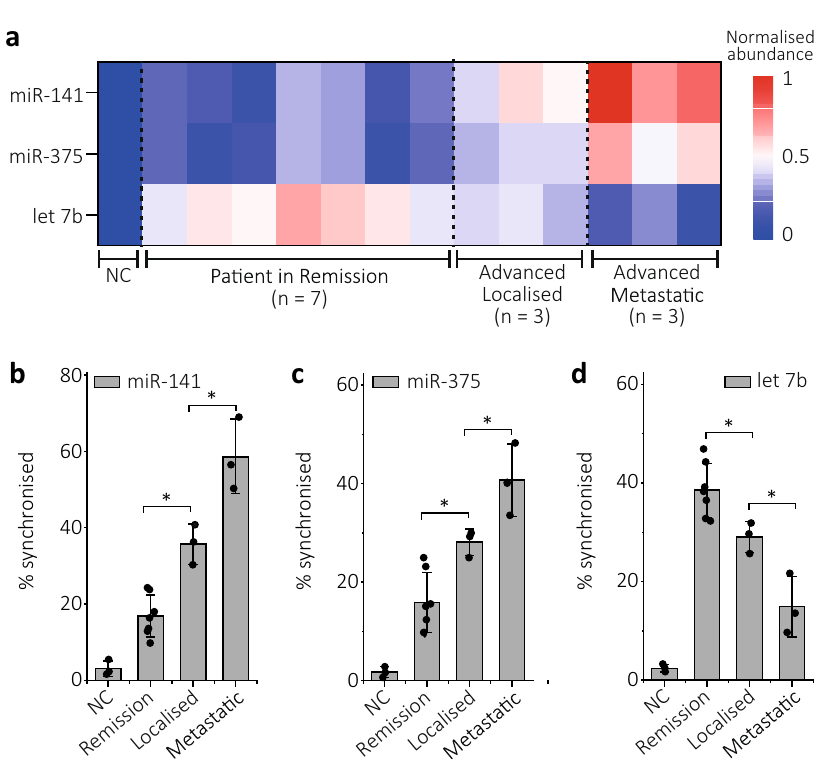
Fig. 6 Mapping of 3 miRNAs to classify prostate cancer stages. a Heat map of two up-regulated (miR-141-3p & miR-375-3p) and one down-regulated (let-7b) miRNAs in prostate cancer patients with advanced localised ( n = 3), metastatic ( n = 3) disease and patients in remission ( n = 7). NC, negative control. b – d Relative expression levels of b miR-141-3p, c miR-375-3p and d let-7b in negative controls, remission patients, advanced localised and metastatic disease patients. Values described were obtained from 3 technical replicates. Data are presented as mean ± s.d. Statistical signi fi cance was tested using two-tailed Student ’ s t -test; * P < 0.05. For localised disease, P = 0.001, 0.0117 and 0.0246 for miR-141-3p, miR-375-3p and let-7b, respectively. For metastatic, P = 0.0222, 0.0497 and 0.0238, for miR-141-3p, miR-375-3p and let-7b,